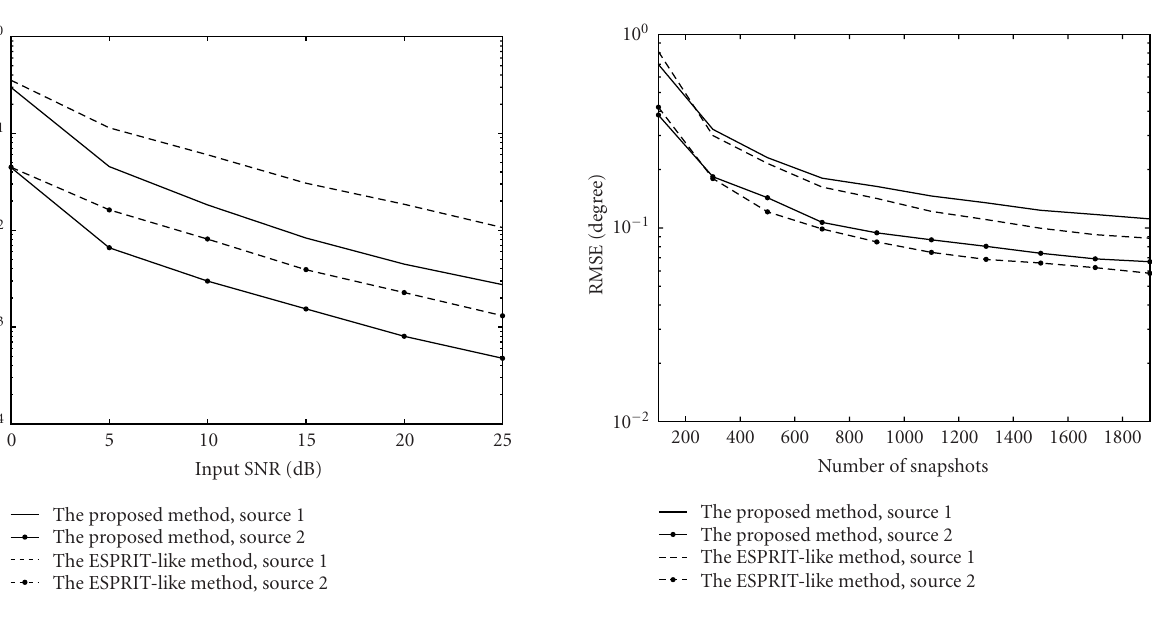
Figure 3: The RMSE of the estimated range over 500 Monte-Carlo runs versus the input SNR; 14 sensors and 1000 snapshots are used, and the two equi-power sources approach the array from 38 ◦ and 20 ◦ , respectively.